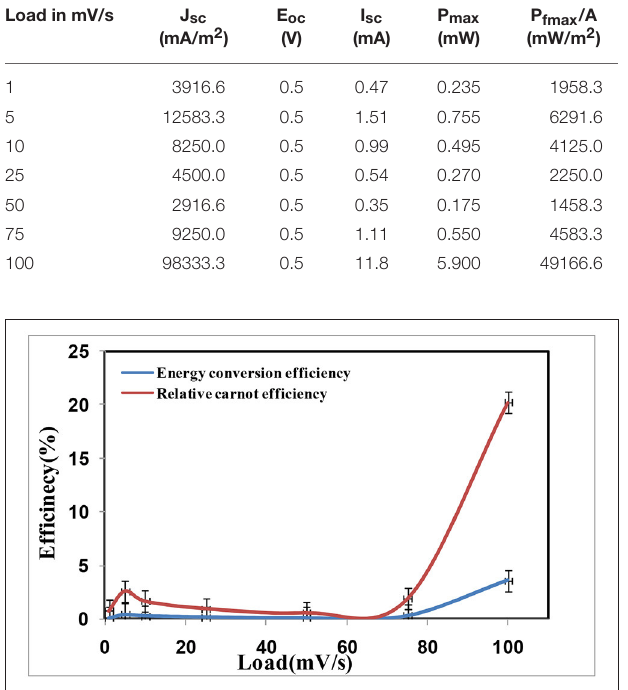
FIGURE 4 | Energy Conversion and relative carnot efficiency of the device at 1 T = 60 ◦ C.